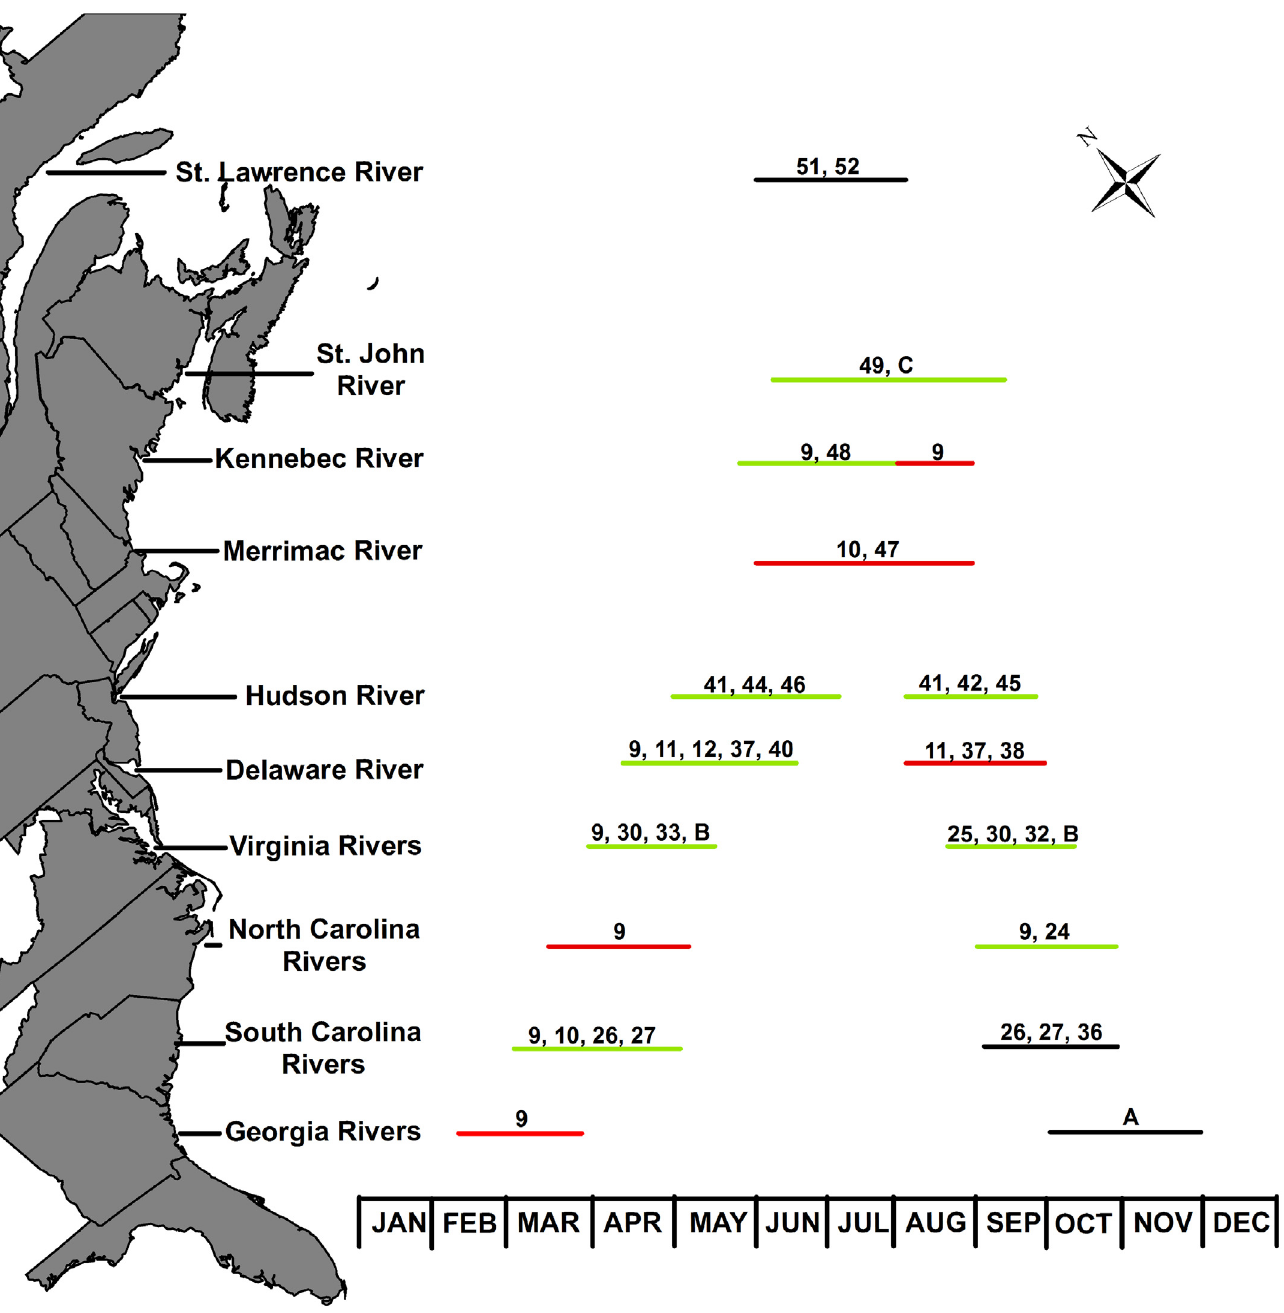
Fig 4. Map with bars showing spawning months of certain areas along the Atlantic sturgeon ’ s range. Red lines are spawning periods just described in historical records, black lines are relatively recent data, and green lines were described in both recent and historical records. Numbers refer to the references used to estimate spawning periods, letters are as follows: A, Peterson (Unpublished Data); B, This Paper; C, Cornel Ceapa (Personal Communication).